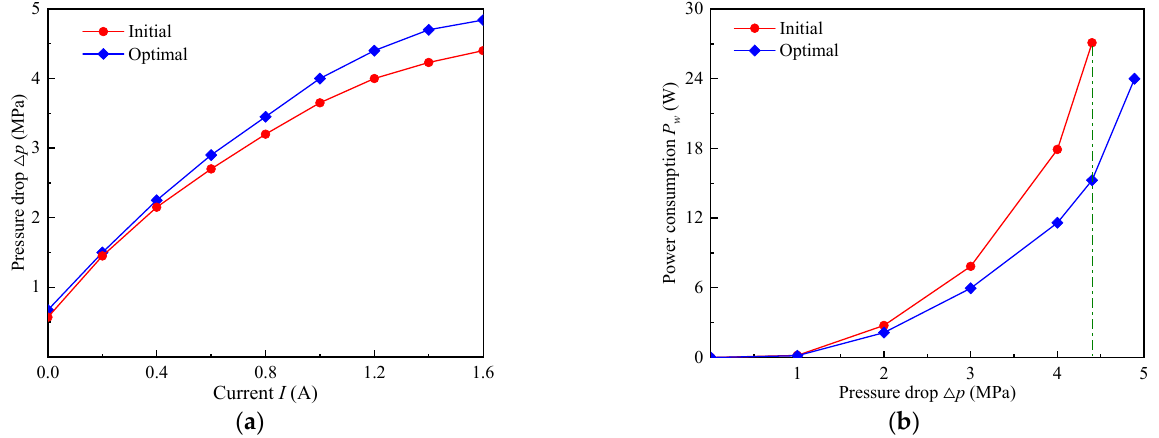
Figure 13. Comparison of the initial and optimal performance indicators: ( a ) pressure drop Δ p , ( b ) power consumption P w.